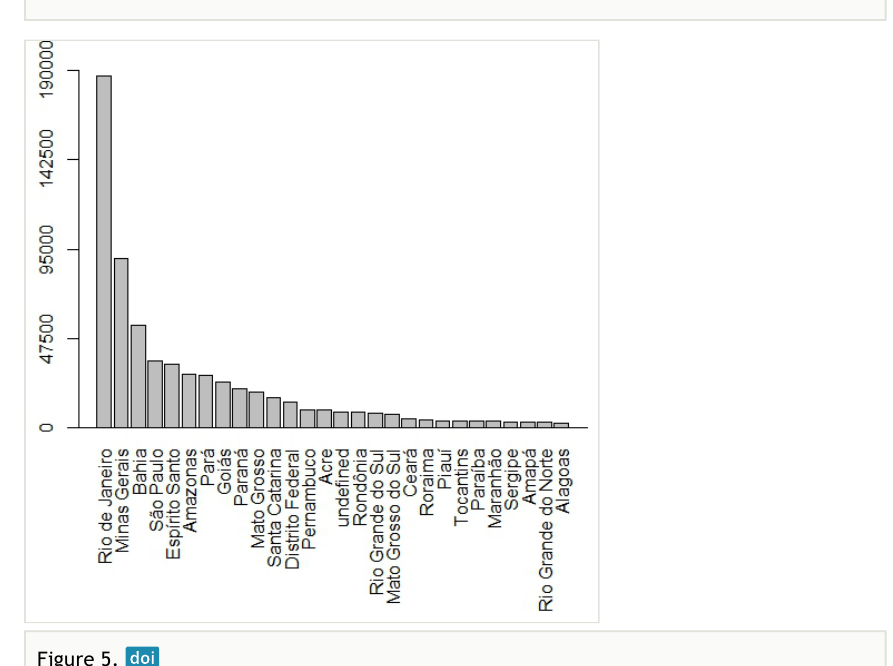
Figure 4. Number of specimens databased in JABOT system per year.